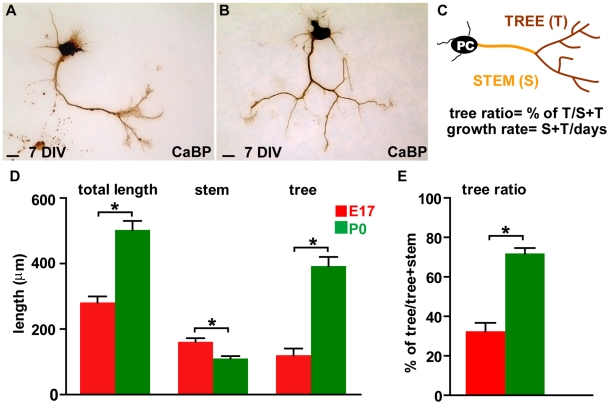
Axon growth pattern of embryonic and postnatal Purkinje cells at 7 days in vitro.(A, B) Representative images of calbindin-labeled (CaBP) Purkinje cells (PCs) dissociated at embryonic day 17 (E17) or postnatal day 0 (P0) and cultivated for one week. (C) The cartoon depicts the PC axon compartments considered for the analysis (axon stem, orange, and terminal arbour, brown) and the indexes calculated for morphometric evaluation (tree ratio, growth rate). (D, E) Histograms compare the averages of total length (stem+terminal tree), stem axon length (neuritic segment between the soma and the beginning of the terminal tree), terminal tree (sum of the lengths of segments composing the terminal arbour), and of the tree ratios of cultured E17 and P0 PCs. Asterisks indicate statistically significant differences between E17 and P0 PCs (Mann-Whitney Test, P<0.001). Error bars, SEM. Scale bars, 25 µm.